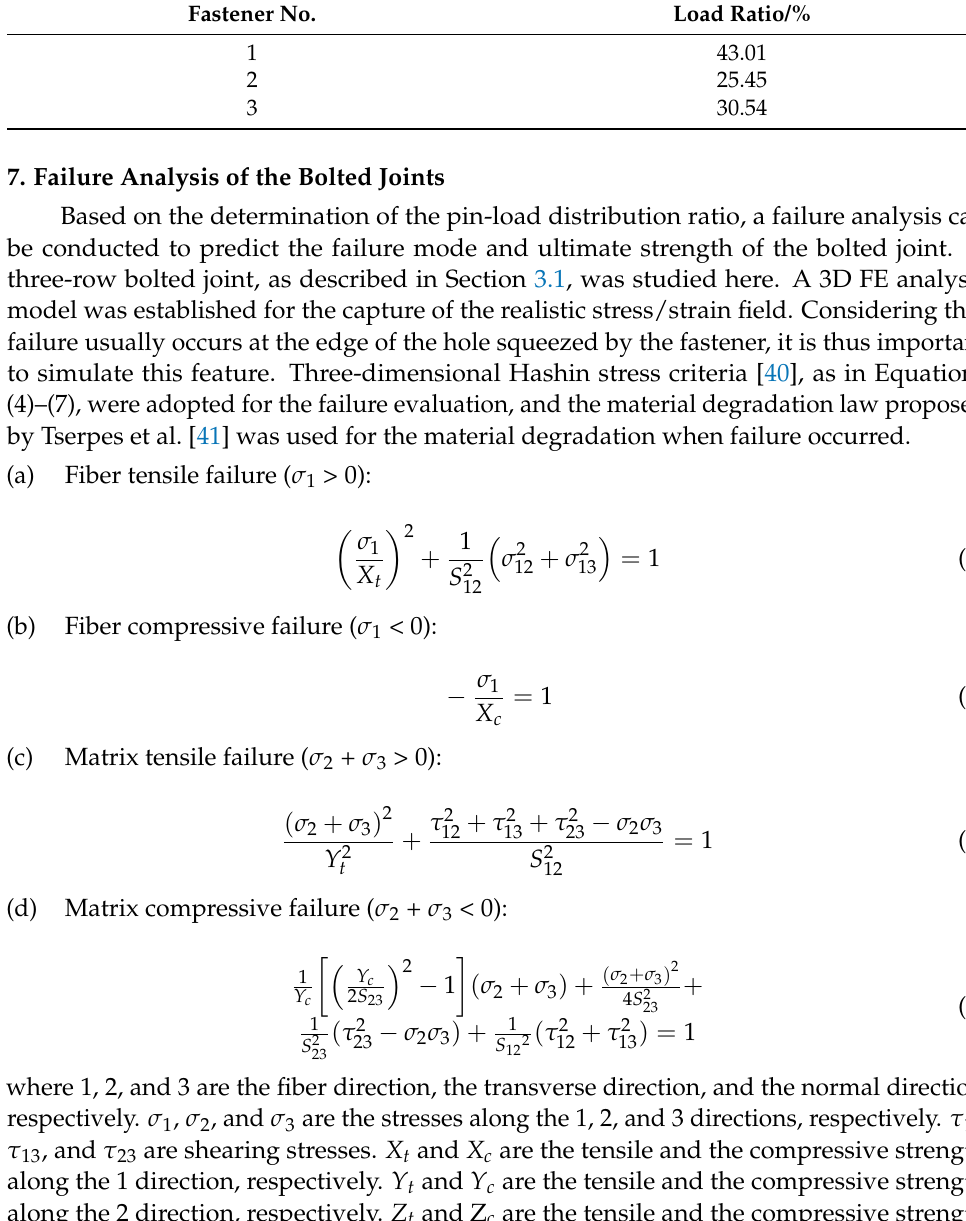
Table 5. The pin-load distribution ratio of three-row fasteners from the 3D FE model. Fastener